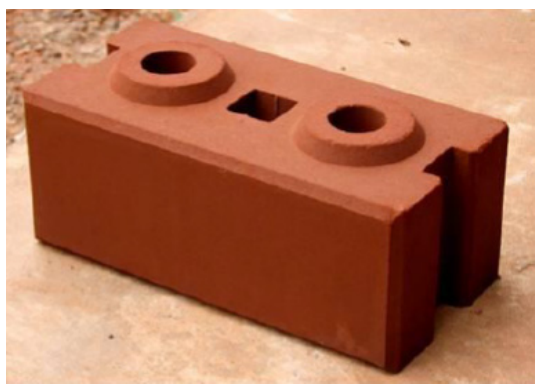
Figure 5. CCIH brick. Figure 5. CCIH